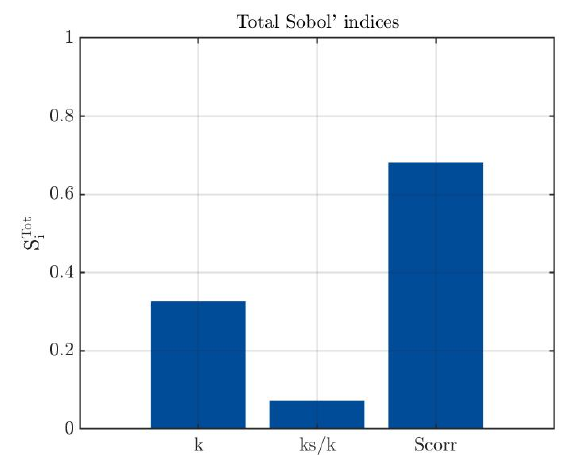
Figure 11. Total Sobol indexes for metamodel M 2 and the HAX thermal correction